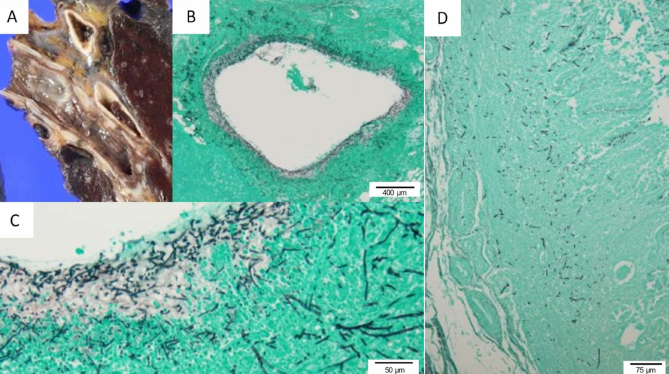
Figure 5. Macroscopic and histological findings: ( A ) the bronchus was covered with pseudomem- branes. Erosion and necrosis were found on the bronchial wall, with sputum and necrotic material attached; ( B ) fungus invades deep into the bronchial wall (Grocott stain, magnification: × 40); ( C ) bronchial wall was destroyed by Aspergillus (Grocott stain, Magnification: × 100); ( D ) in the gastric mucosa, Aspergillus invasion was observed, and there was no ulcer lesion (Grocott stain, magnifica- tion: ×